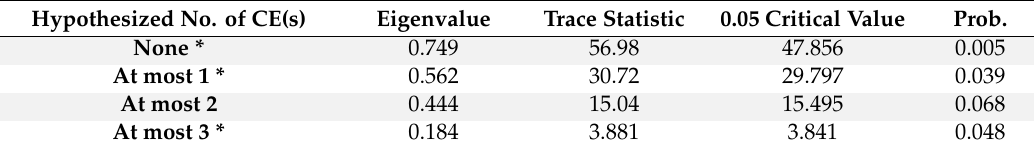
Table 2. Unrestricted Cointegration Rank Test (Trace).